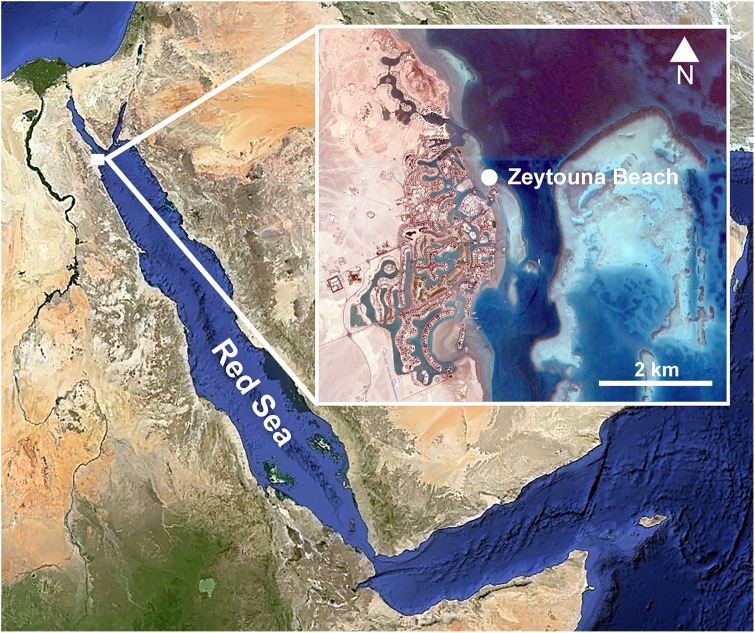
Location of the sampling site.Zeytouna Beach, Egyptian coast of the Red Sea. Maps are from Google Earth Pro, © 2016 DigitalGlobe, © 2016 CNS/Astrium.